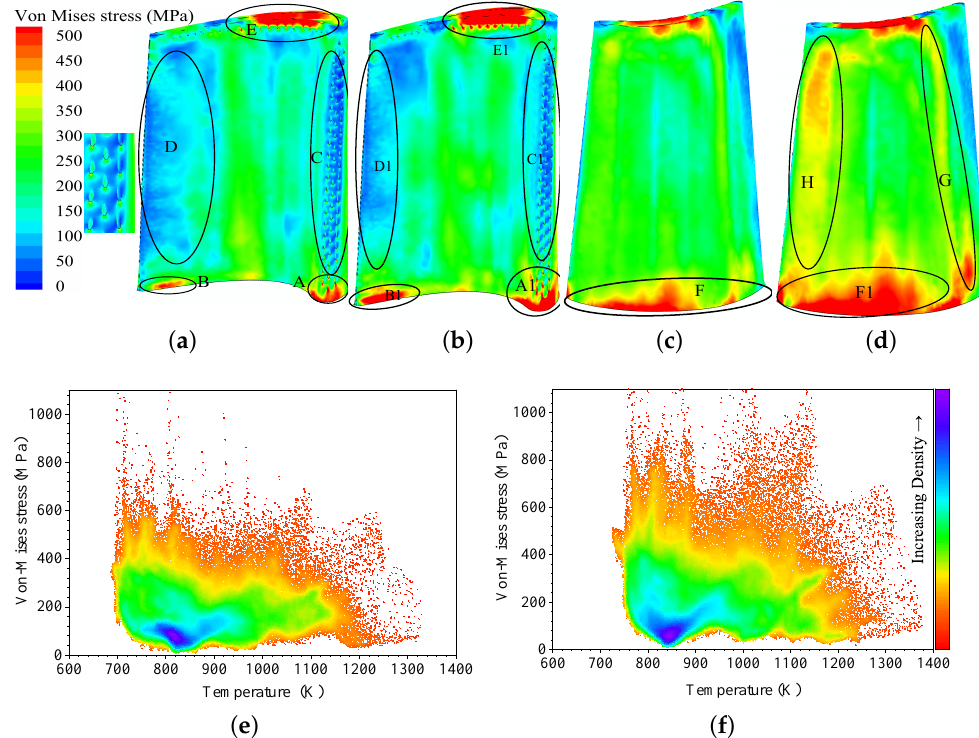
Figure 10. Von Mises stress distribution of the rotor blade: ( a ) pressure side, ( c ) suction side, and ( e ) thermo-stress state under the rotating condition; ( b ) pressure side, ( d ) suction side and ( f ) thermo- stress state under the stationary condition (A,B and E–H show the local stress concentration areas; C and D show low-stress